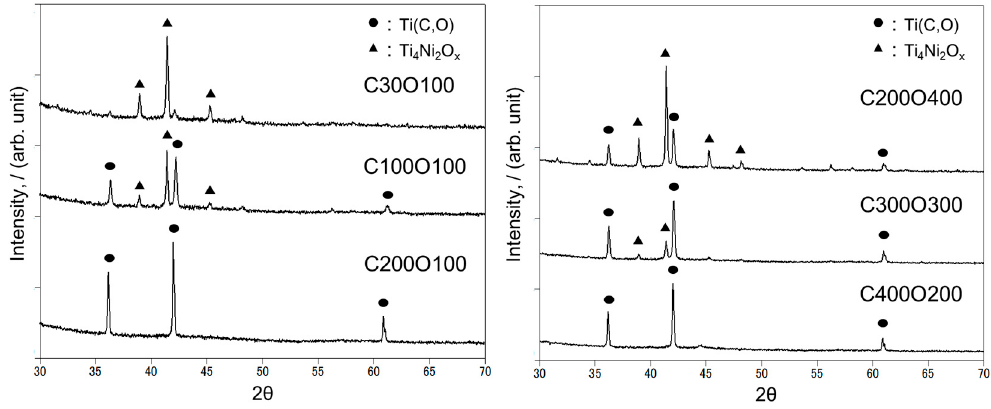
Figure 3. X-ray diffraction (XRD) patterns of nonmetallic inclusions extracted from six wire samples by selective potentiostatic etching by electrolytic dissolution (SPEED) technique.